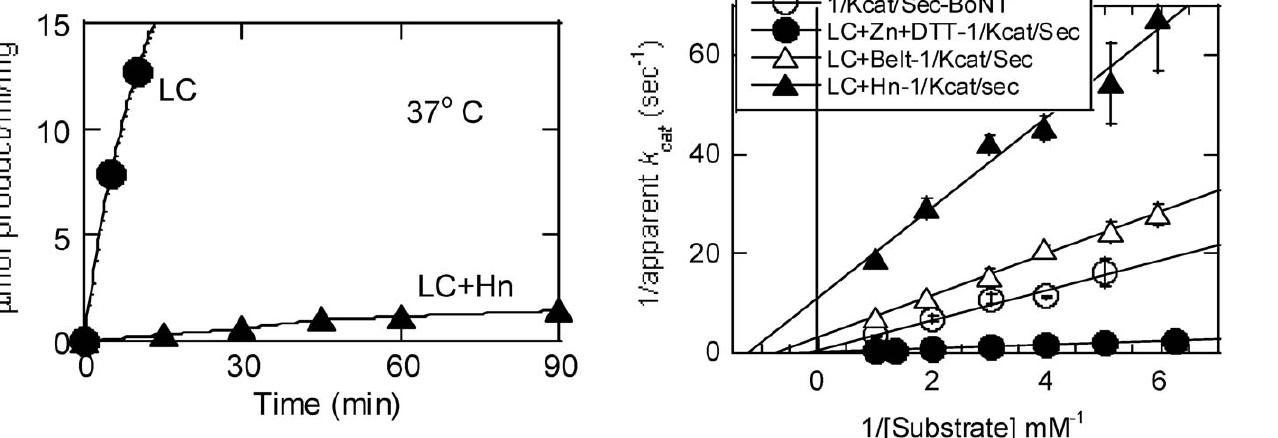
Figure 7. Lineweaver-Burke plots of reaction velocity versus substrate concentration of reactions catalyzed by three LC variants. The bars accompanying the data points are standard deviations of three to five assays. LC (closed circle), LC + Belt (open triangle), LC + Hn (closed triangle), and BoNT/A (open circle).